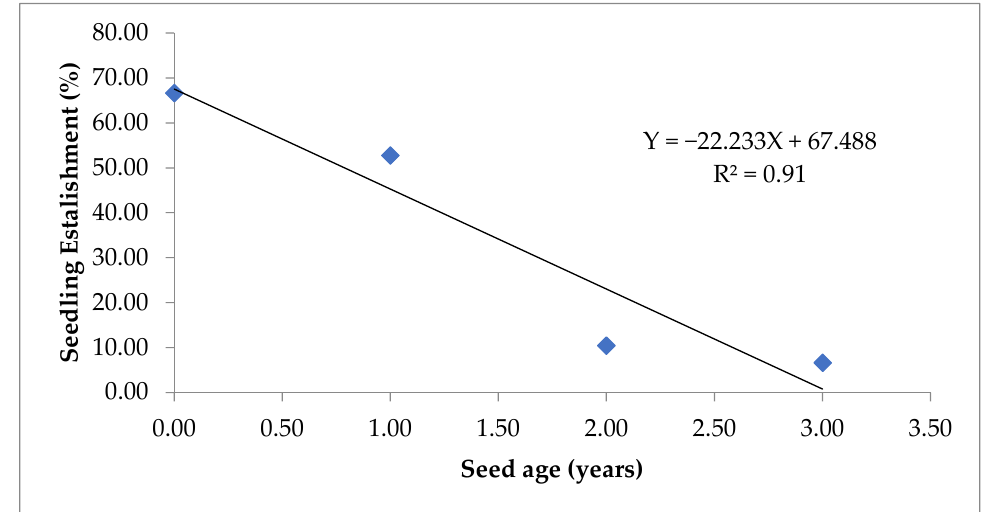
Figure 7. Simple linear regression between seed age and seedling establishment (%).